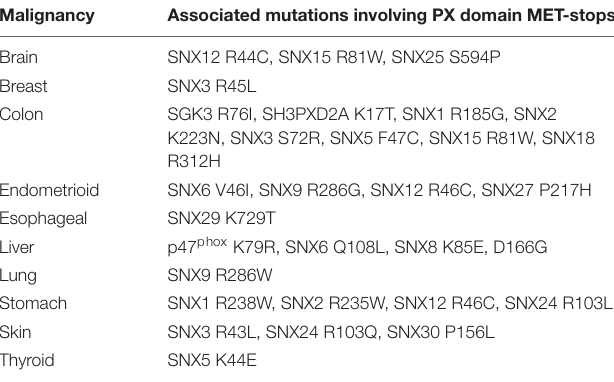
TABLE 3 | Cancer-linked point mutations involving MET-stop motifs of human PX